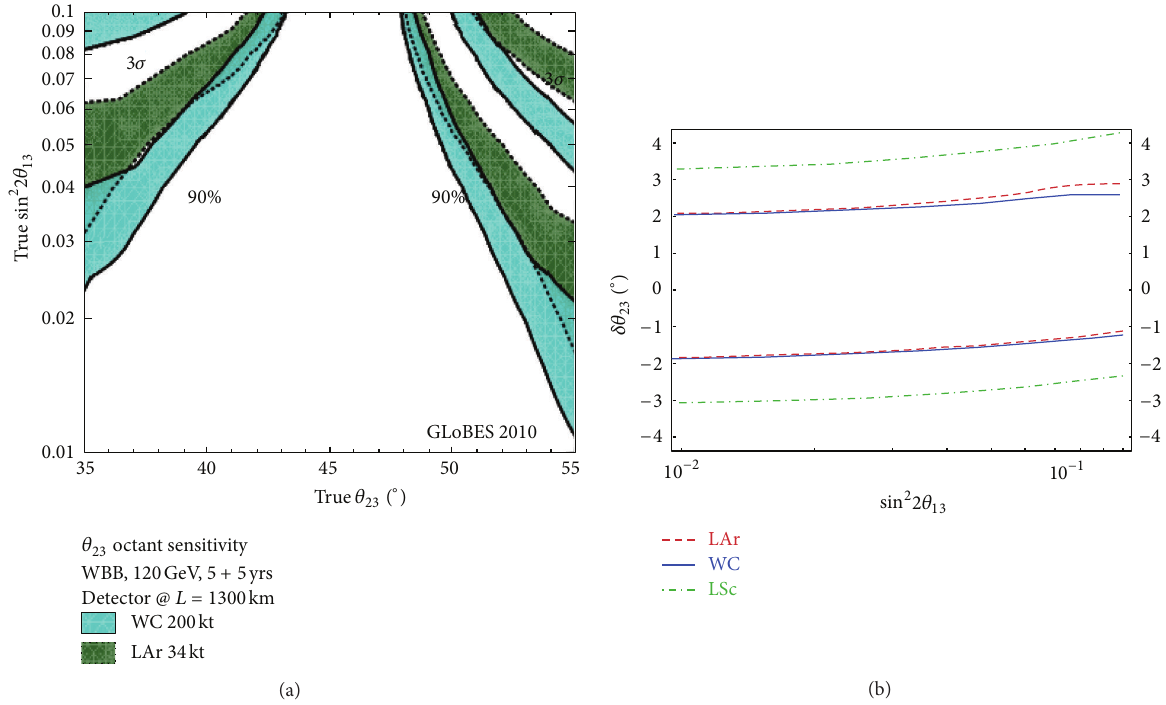
Figure 20: (a) LBNE sensitivity to resolve the 𝜃 23 octant degeneracy. The standard configuration in 2010 has been used. The blue (green) band shows the results for 200kt WC (34 ktLAr) and its width is obtained by varying 𝛿 , ranging from 10% to 90% CP fraction. In the region above the bands, the 𝜃 23 octant can be determined at 90% CL (lower bands) and 3𝜎 (upper bands). Taken from [103]. (b) Nonmaximal 𝜃 23 discovery potential, with 𝛿𝜃 23 ≡ 𝜃 23 − 45 ∘ , as a function of sin 2 2𝜃 13 , for the LBNO superbeam with 100kton LAr, 440kton WC and 50 kton LSc detectors. In the region enclosed by each couple of lines, 𝛿𝜃 23 = 0 cannot be ruled out at a statistical significance of 3 𝜎 . Results are shown for the detector placed at Pyh¨asalmi and for a true normal hierarchy. Figure taken from [107].